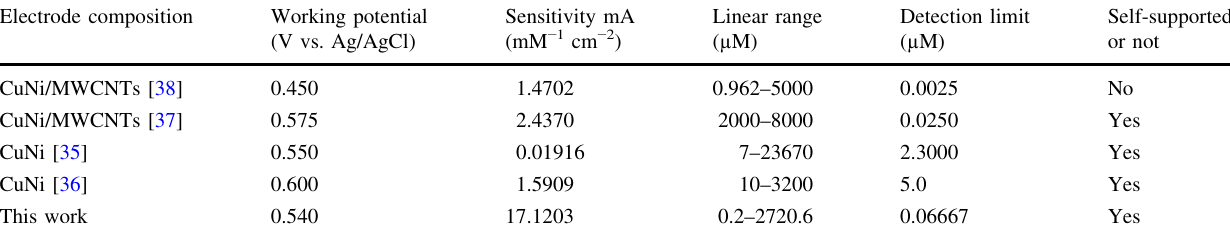
Table 1 Comparison of CuNi/C glucose sensor with previously reported Ni-based non-enzymatic glucose sensors Electrode composition Working potential (V vs.